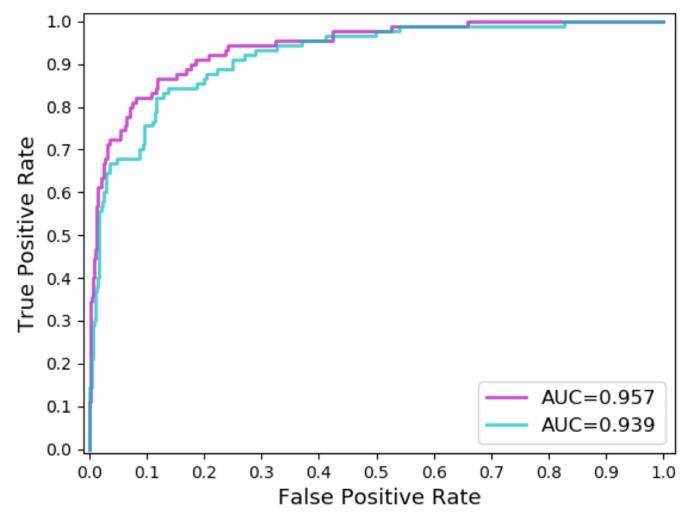
Figure 6. The red and black lines represent the result curves of ARDT-DenseNet100 and DenseNet100, respectively.